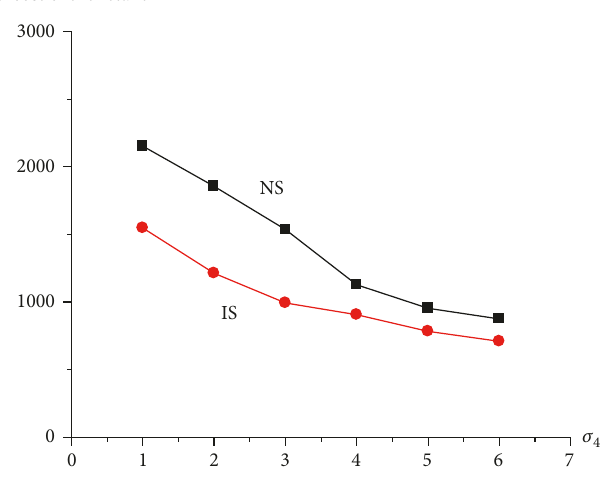
Figure 9: Transportation uncertainty versus the retailer’s costs under two